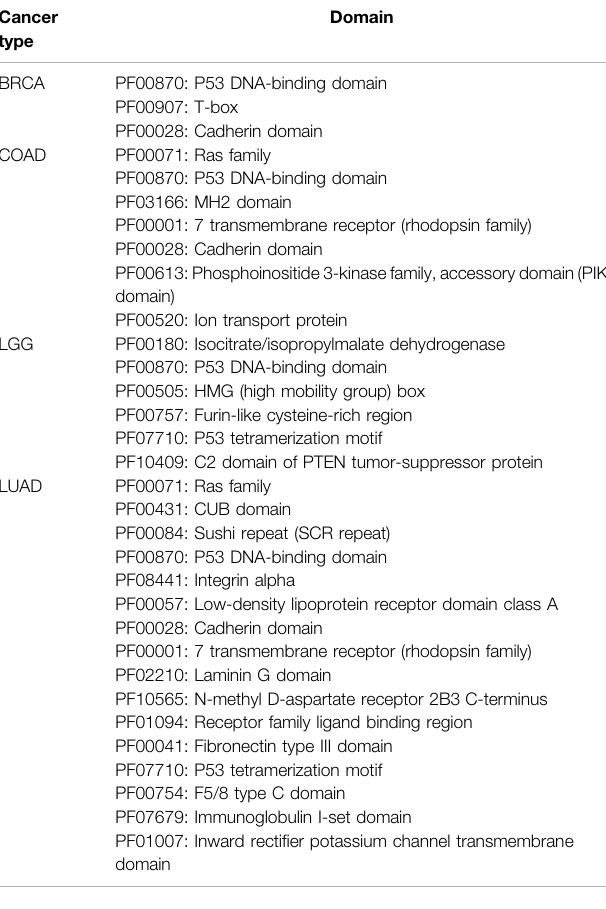
TABLE 2 | Domains contributing to models for the cancer type.